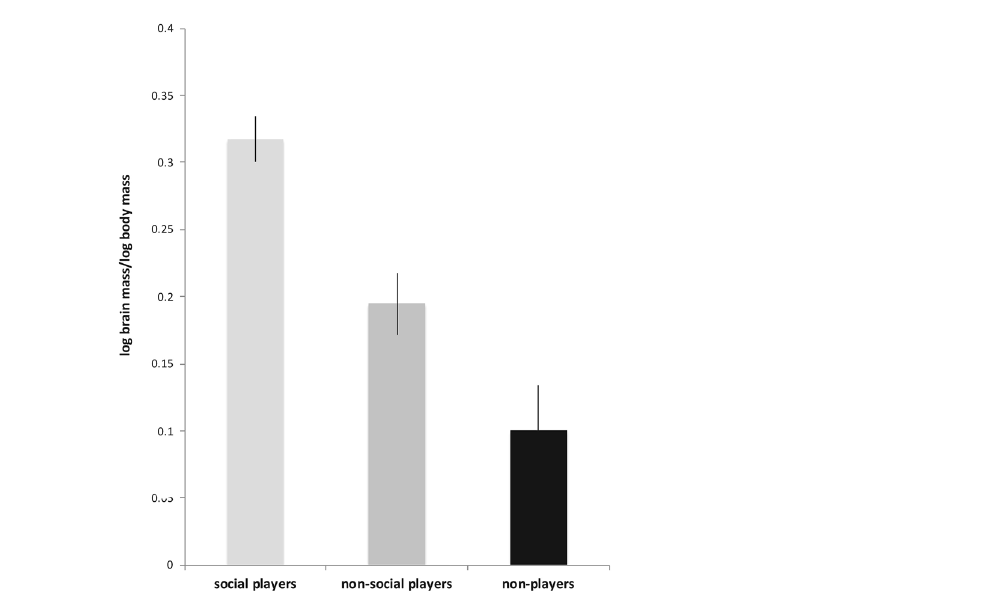
Figure 4. Type of play is associated with relative brain mass. Relative brain size is highest for social players, but even non-social players (solo or object play) have significantly larger brains than